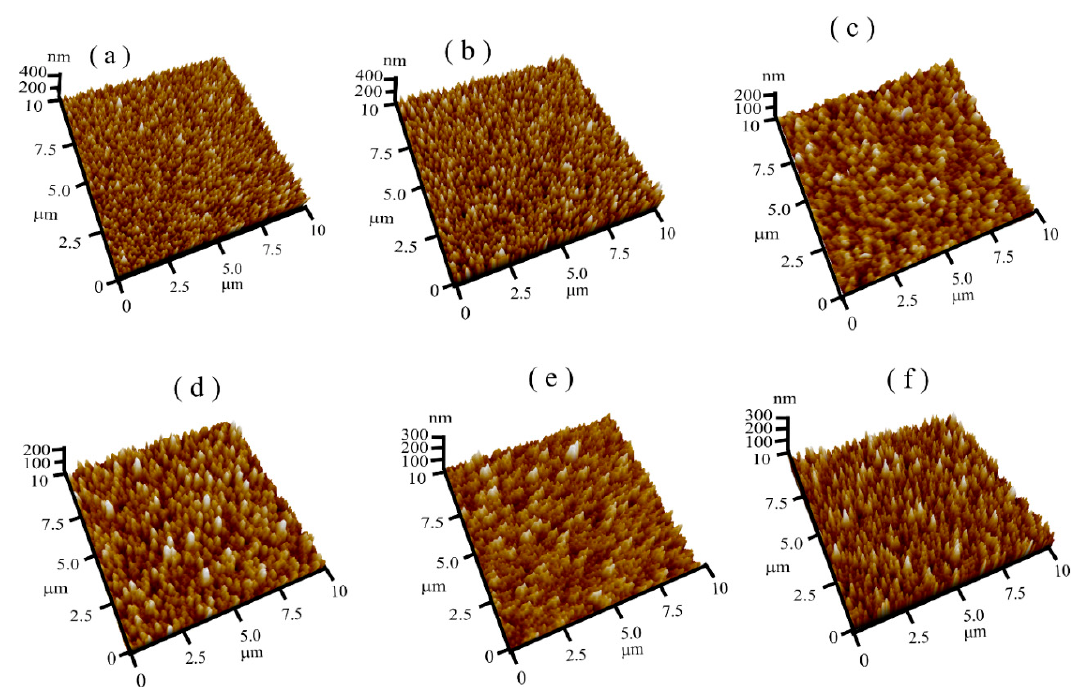
Figure 5. Three-dimensional AFM images of the ZnO nanorods doped with different Mg contents: ( a ) undoped ZnO, ( b ) 1%, ( c ) 2%, ( d ) 3%, ( e ) 4%, and ( f ) 5%.